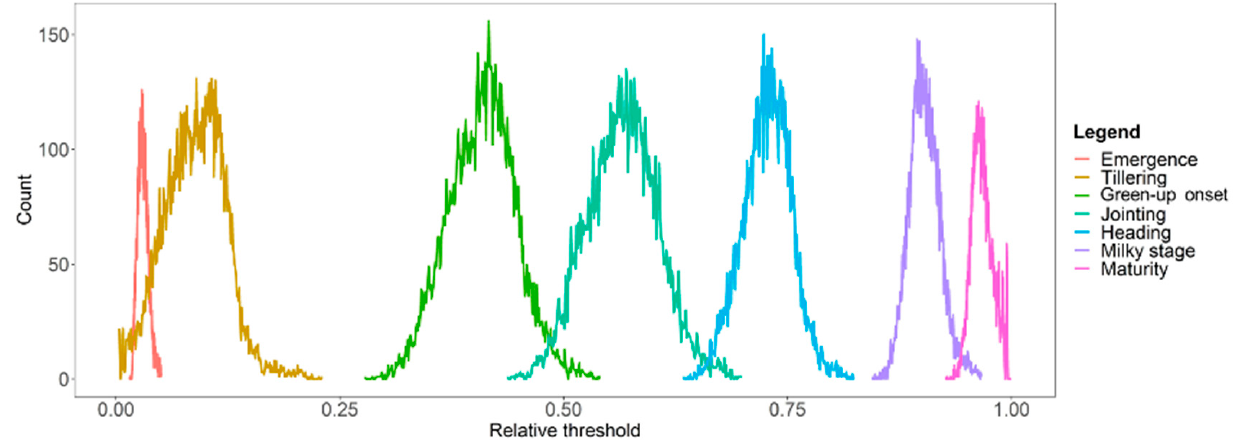
Figure 12. Histogram distribution of the relative thresholds of wheat phenology.